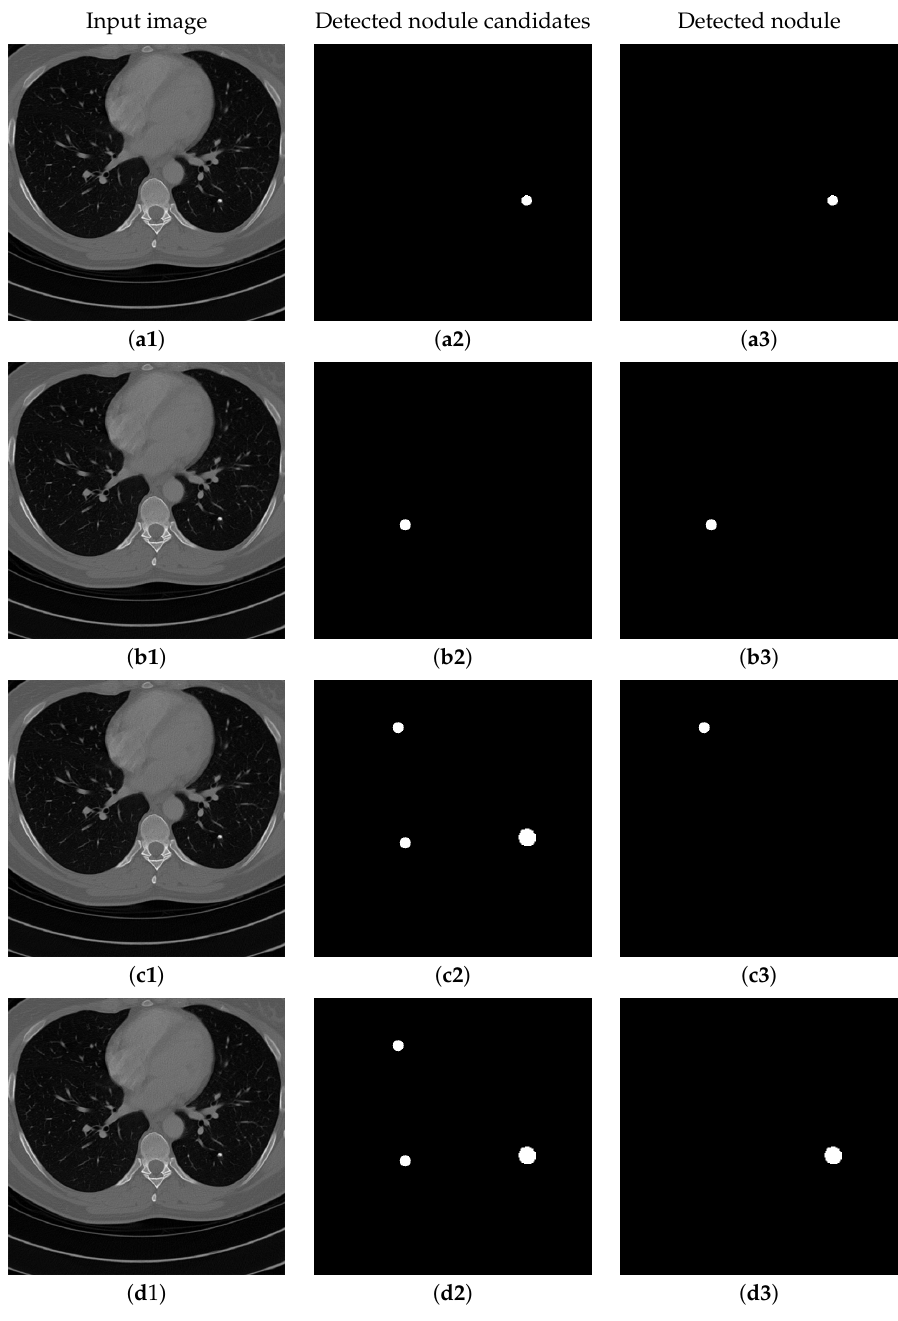
Figure 15. The results of detecting pulmonary nodule through the proposed network with different loss strategies. Columns from left to right are: input images, detected nodule candidates, detected nodules. Rows from top to bottom are: ground truth detection results, nodule candidates and nodule detection by the proposed network with MSE loss, MSE-perceptual loss and the MSE-perceptual-dice loss. Table 7. Quantitative results associated with different combinations of losses of the proposed network for detecting nodules from the